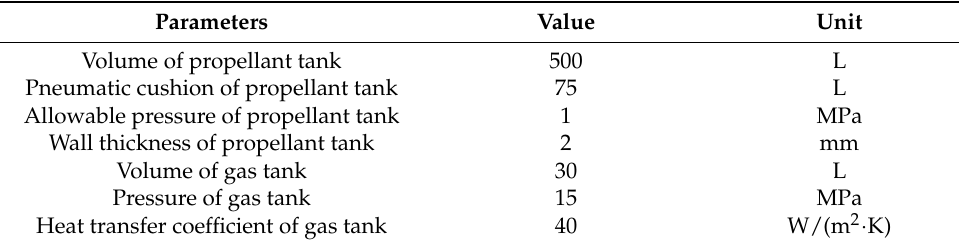
Table 5. Main parameters of the propellant tank and the gas